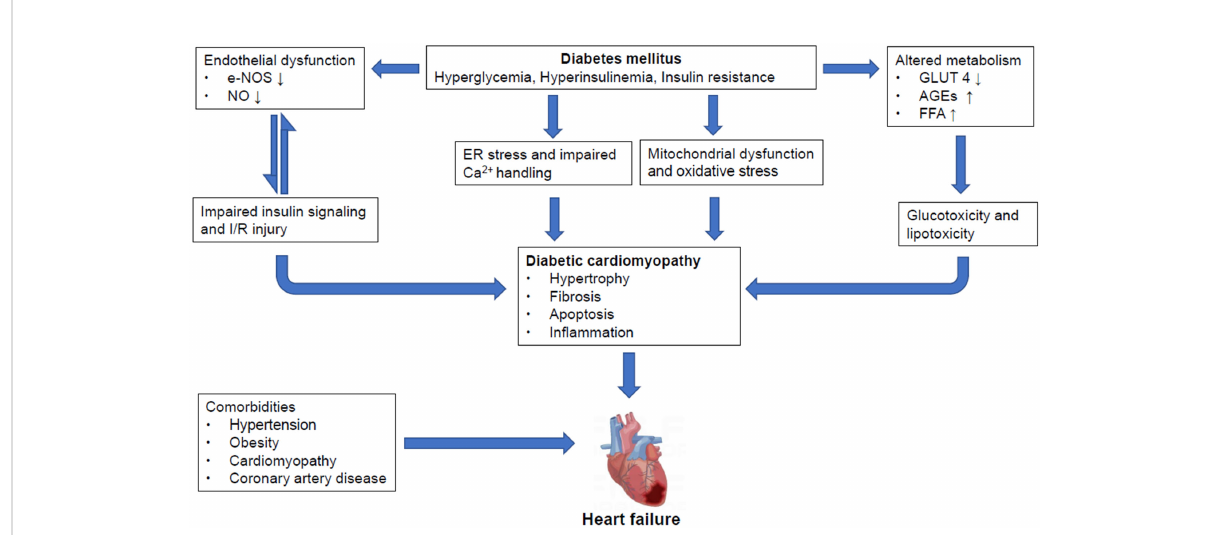
FIGURE 1 Overview of pathological mechanisms underlying diabetic cardiomyopathy and heart failure in diabetic mellitus Pathological stresses such as hyperglycemia, hyperinsulinemia and increased insulin resistance induce endothelial dysfunction through suppression of eNOS and nitric oxide (NO) production, causing impairments in insulin signaling which could further damage the integrity of endothelial tissues. And, reciprocal relationships exist between insulin resistance and endothelial dysfunction. Moreover, these instigators also alter metabolism by reducing GLUT4 expression, increasing AGEs and FFA production. All of which lead to glucotoxicity and lipotoxicity. Meanwhile, ER stress and impaired Ca2+ handling also occur, along with mitochondrial dysfunction and oxidative stress. These, together, cause myocardial hypertrophy, fi brosis, apoptosis and in fl ammation, contributing to the formation of diabetic cardiomyopathy (DCM) which may proceed to heart failure (HF). However, it is also important to point out that diabetic patients may often have other comorbidities including but not limited to hypertension, obesity, cardiomyopathy and coronary artery diseases that may result in HF. NO, nitrogen oxide; IR, ischemic reperfusion; AGEs, advanced end glycation products; ER, endoplasmic reticulum; DCM, diabetic cardiomyopathy; HF, heart